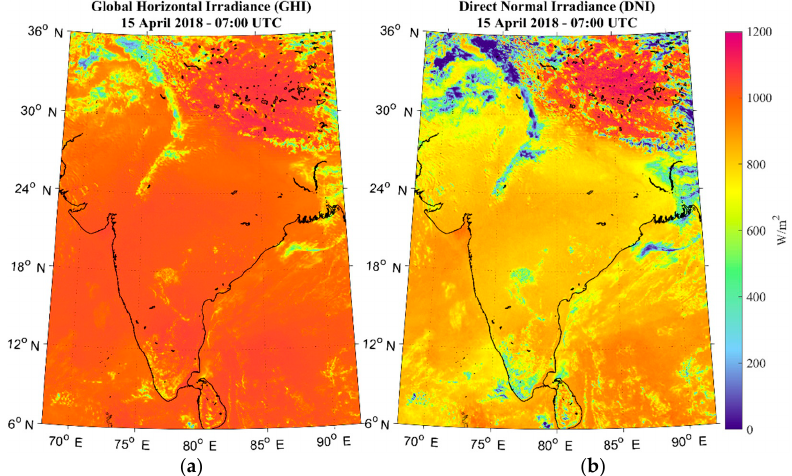
Figure 3. Output map based on INSIOS for 15 April 2018 at 07:00 UTC (Coordinated Universal Time) for India for ( a ) GHI and ( b ) DNI.